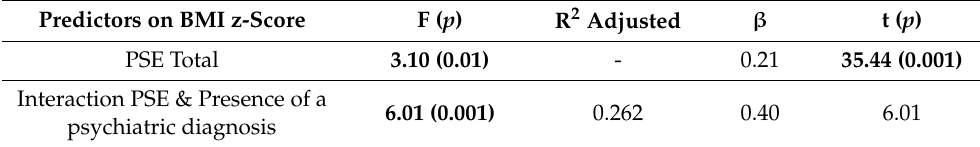
Table 4. Linear regression model on children weight status (BMI